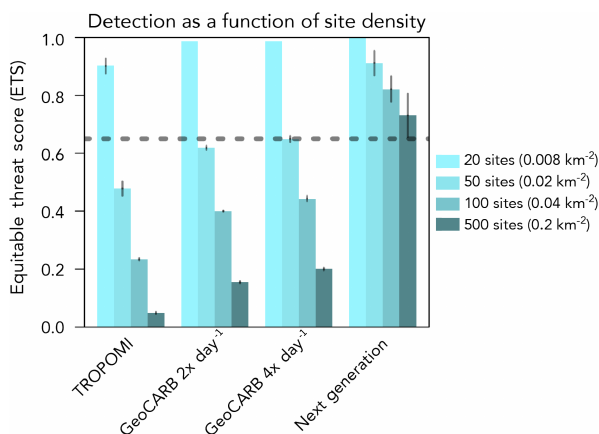
Figure 7. Equitable threat score (ETS) for each satellite observing configuration, varying the density of production sites (20–500 sites in 50 × 50km 2 domain). Results are from the L 1 inversion. The dashed line represents the ETS criterion for successful